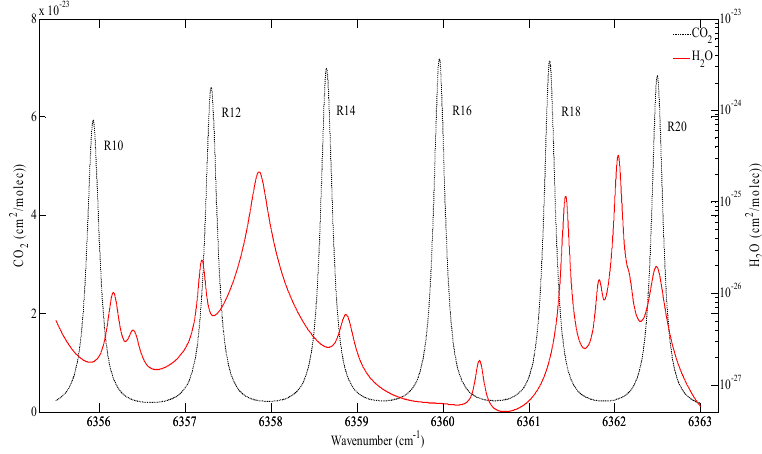
Table 1. Spectroscopic parameters of CO 2 and H 2 O involved in the simulation analysis.